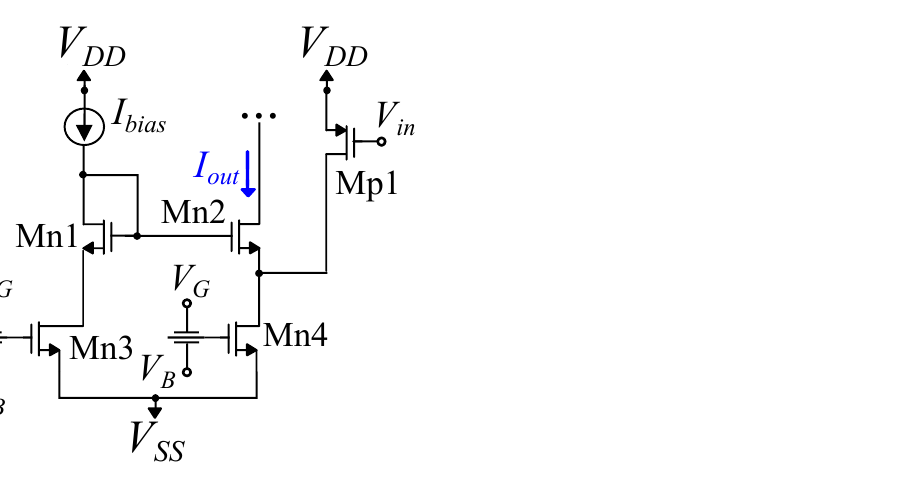
Figure 22. Floating gate transistor level architecture based on an exponentiator circuit for the implementation of the Gaussian function.